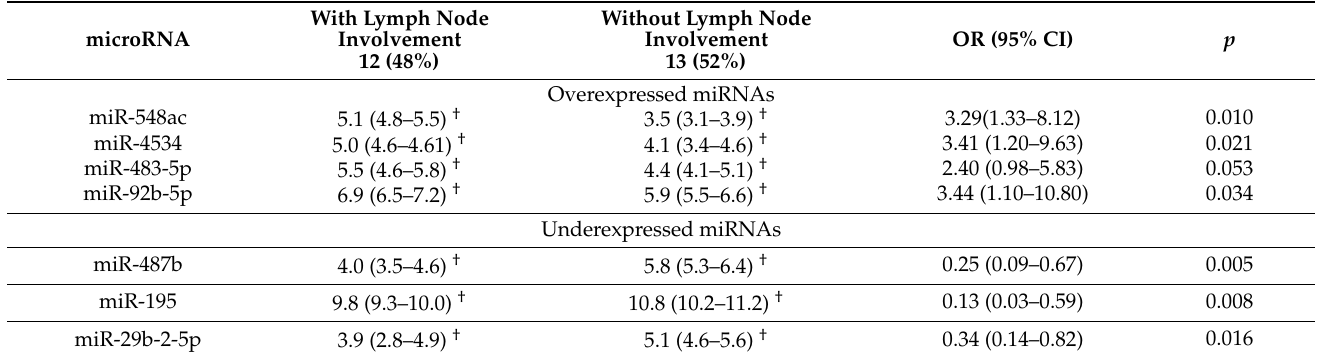
Table 3. Bivariate analysis of miRNAs associated with lymph node involvement in patients